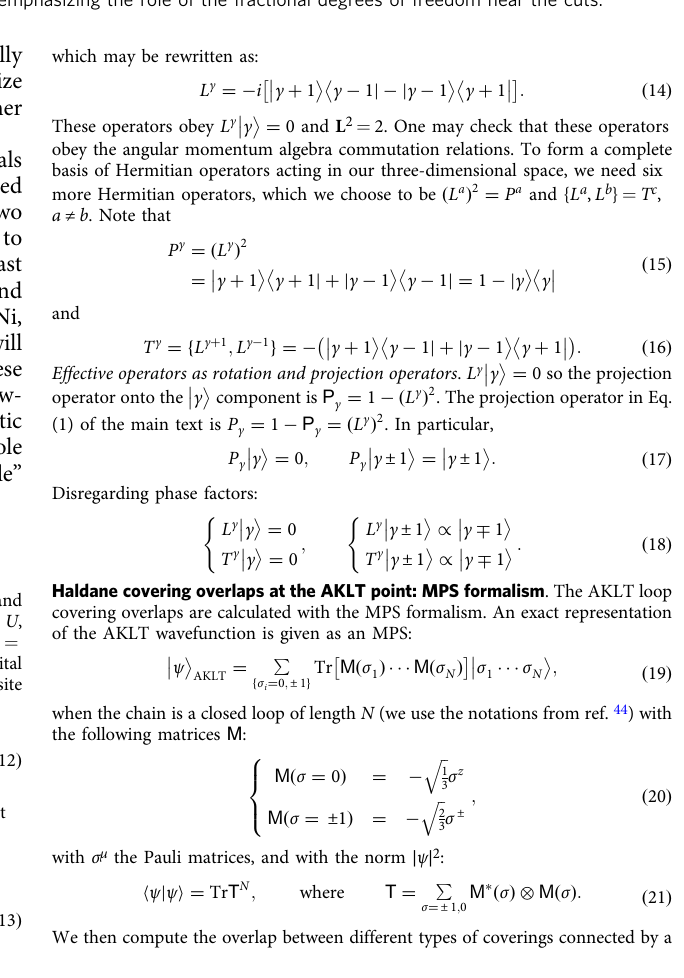
Fig. 8 Transfer matrix overlap representation in the matrix product state formalism. a Overlap between three loops and one loop, b overlap between two sets of two loops and c overlap between one loop and two loops, emphasizing the role of the fractional degrees of freedom near the